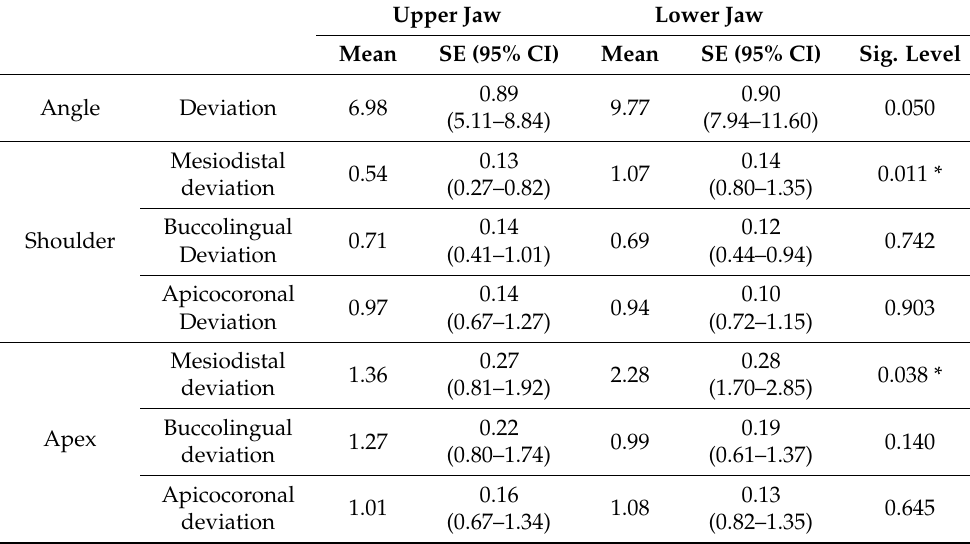
Table 4. Deviations between the planned and achieved implant position according to the jaws. Upper jaw (N = 20) lower jaw (N = 32). Angle variance ( ◦ ). Linear deviation (mm). Kruskal–Wallis test with a significance level of p < 0.05.